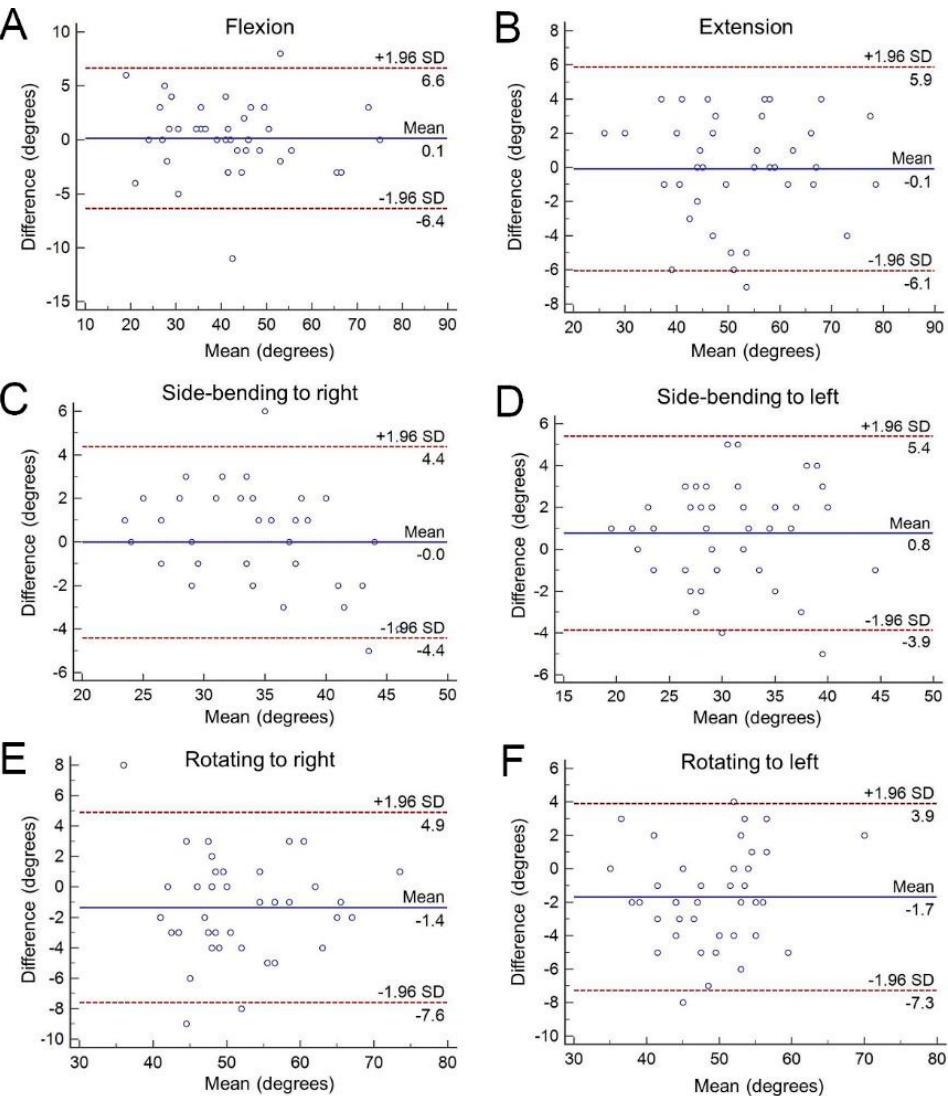
Figure 4. The Bland–Altman plot for craniocervical ranges measured by the hybrid device and universal goniometers in ( A ) flexion, ( B ) extension, ( C ) side-bending to right, ( D ) side-bending to left, ( E ) rotating to right and ( F ) rotating to left. The blue solid line indicates the mean values of all he subjects, whereas the red dotted line refers to its upper and lower limits (mean ± 1.96 standard deviation).